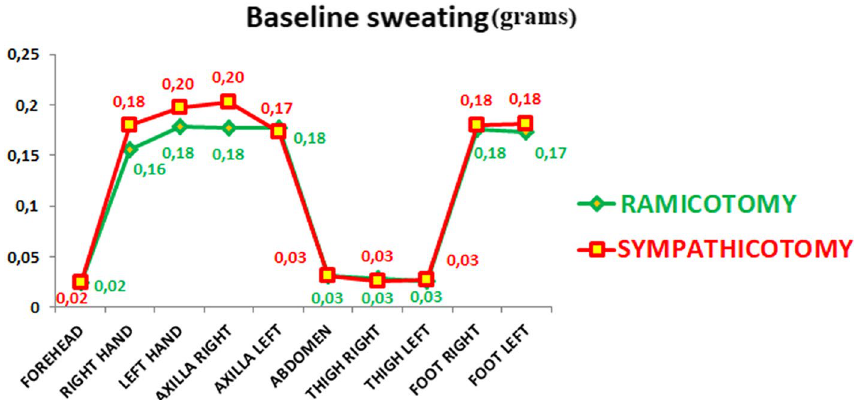
Figure 1. Baseline sweating from the different anatomical areas evaluated.